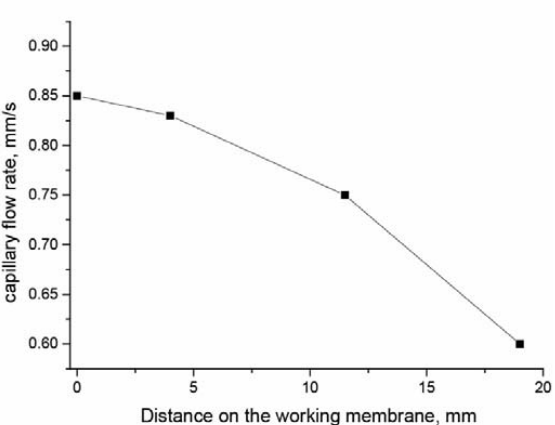
Figure 3. Change in the rate of capillary flow in the course of liquid movement along the working membrane of the test